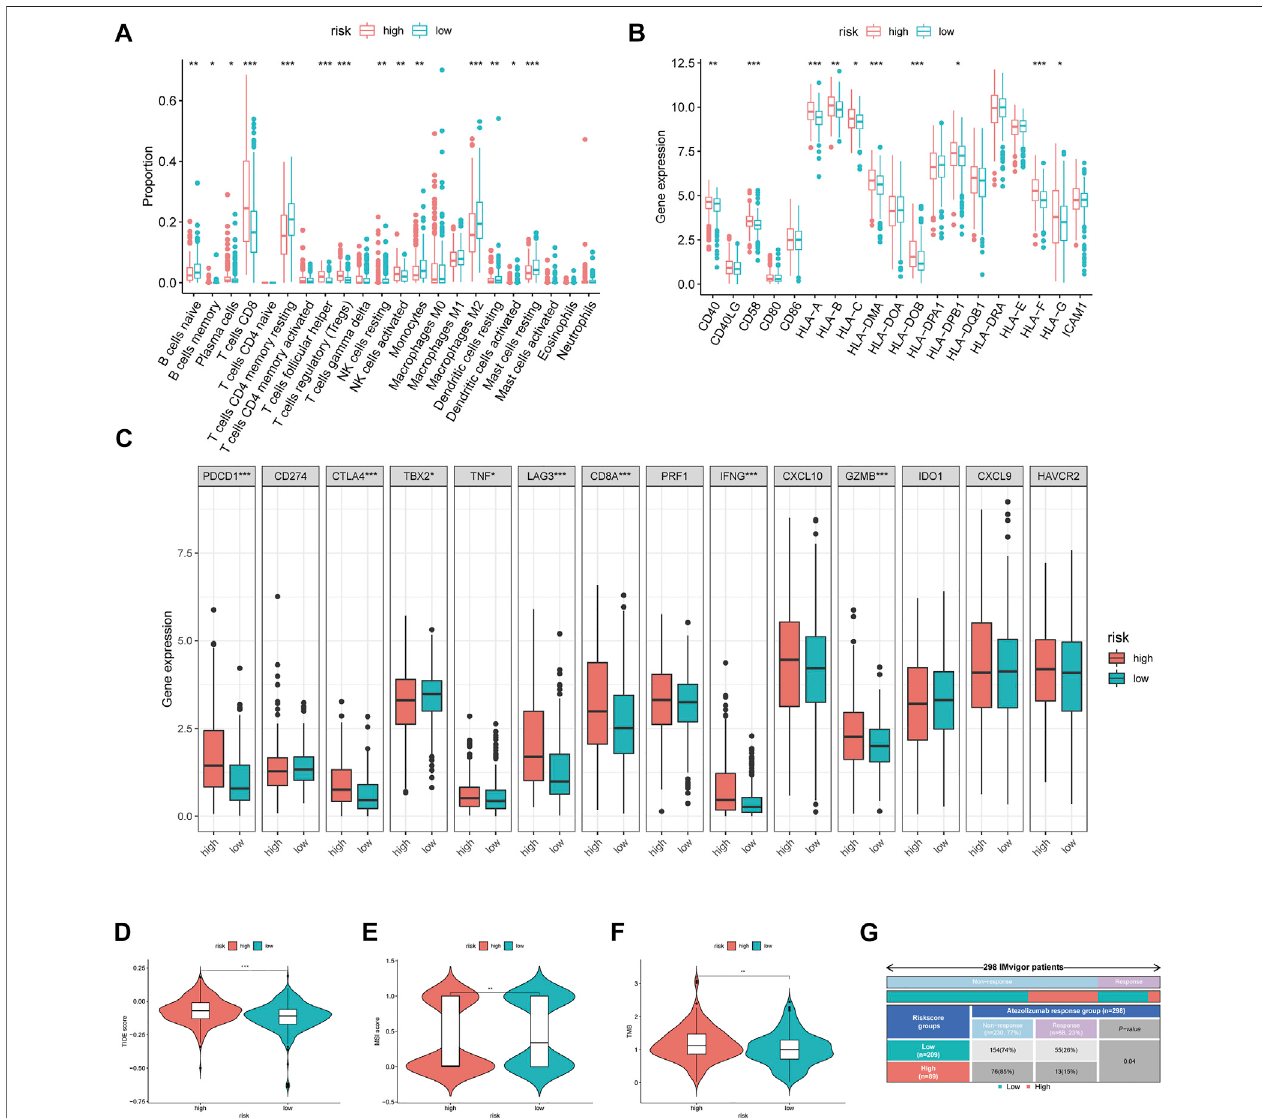
FIGURE5| Immune-relatedanalysisbetweendifferentMRGPSsubgroup. (A) TheproportionsofTMEcellsindifferentMRGPSsubgroups. (B) Relativeexpression of MHC molecules, co-stimulatory molecules, and adhesion factors. (C) Associationof MRGPS with immune checkpoint molecules. (D) TIDE, (E) MSI, (F) TMB score in different MRGPS subgroups. (G) Distribution of immune response to ICIs therapy in different MRGPS subgroups in IMvigor patients. Signi fi cant statistical differences between the two subgroups were assessed using the Wilcoxon test (ns, p > 0.05; *, p < 0.05; **, p < 0.01; ***, p < 0.001).